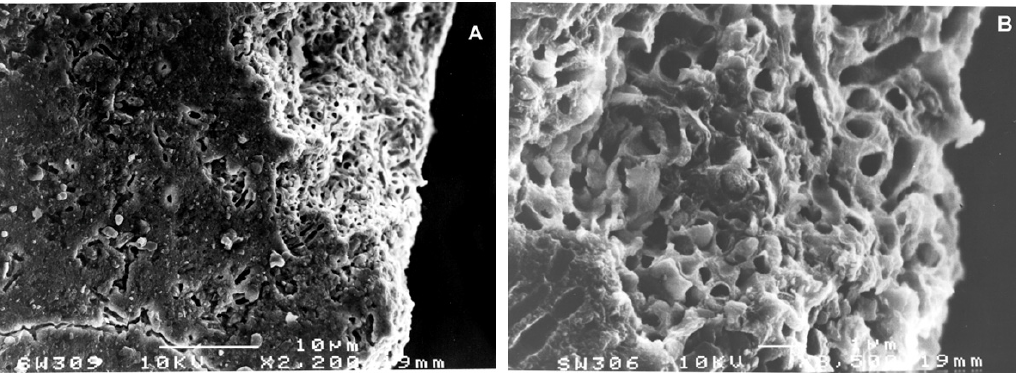
Figure 2. Combe-Grenal IV. ( A ): (picture 306), tartar bacteria at 3500 SEM magnification. ( B ): (picture 304): tartar bacteria at 10,000 SEM magnification, white scale=1 μ m.